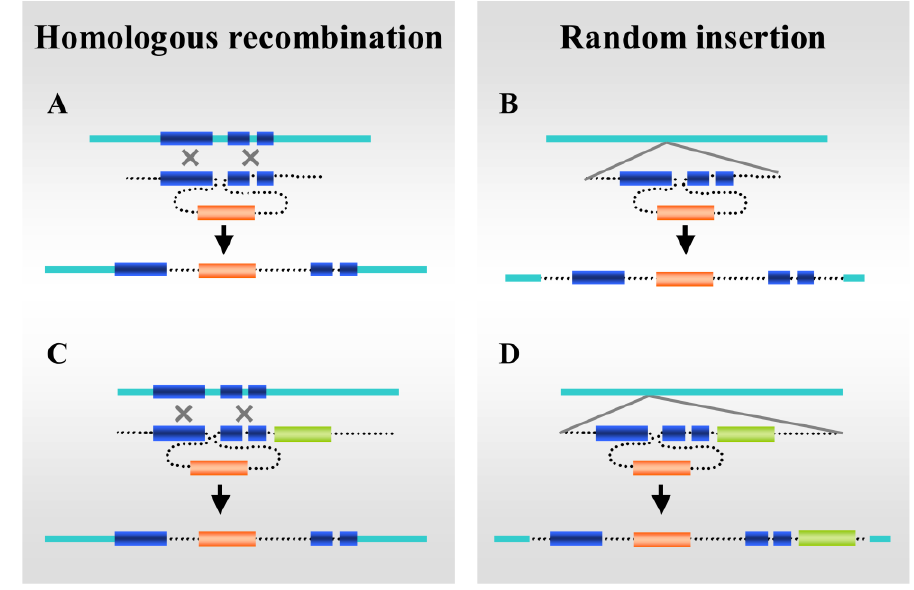
FIGURE 5. Gene targeting by biolistic transformation using counter selection. A and B show the result of a homologous recombination targeting event and a random integration in an unspecific locus of the genome, using a targeting vector containing just one selection marker. Both events are undistinguishable. C and D show the same events when a vector containing two selection markers, such as our targeting construct, is used. In this case, it is easy to discriminate probable homologous recombination events from nonspecific integration